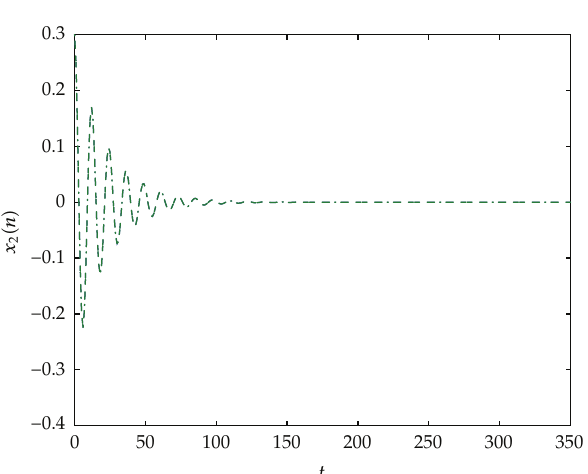
Figure 2: The equilibrium (cid:2) 0 , 0 (cid:3) is asymptotically stable. The initial value and parameter D are (cid:2) 2 , 3 (cid:3) and 38 / 15, respectively.